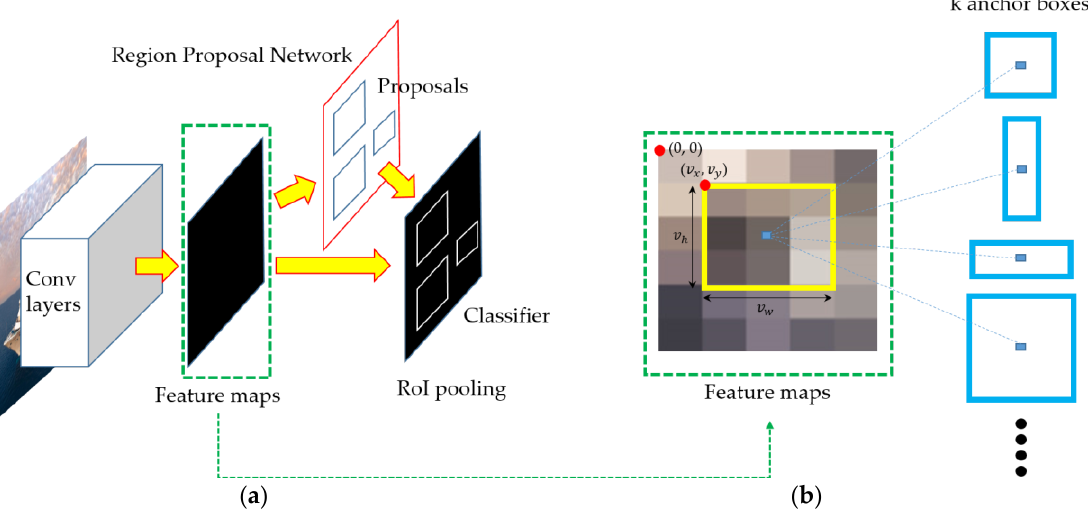
Figure 1. Structures of ( a ) Faster region-based convolution neural network (Faster R-CNN) and ( b ) region proposal network (RPN).